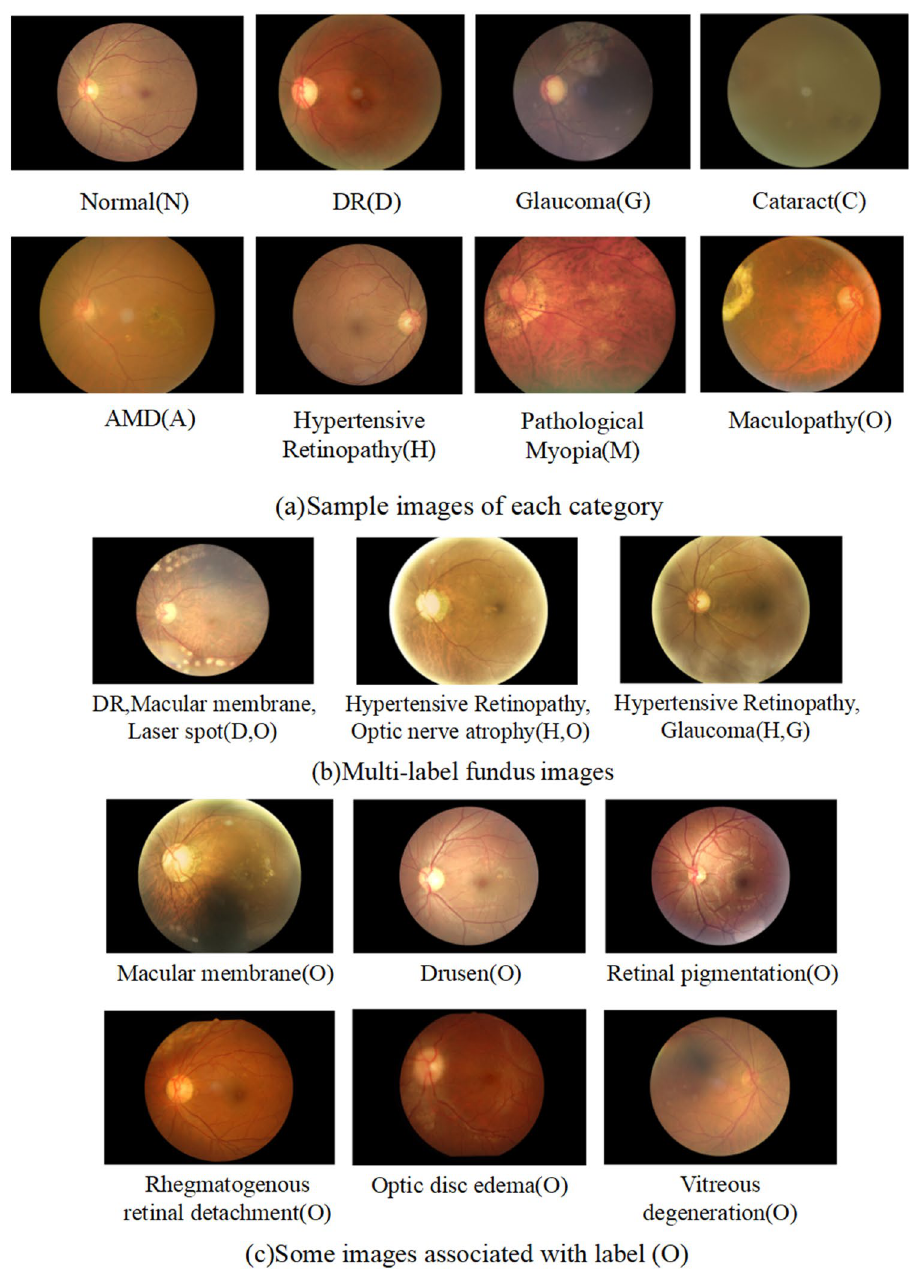
Figure 5. Sample images.